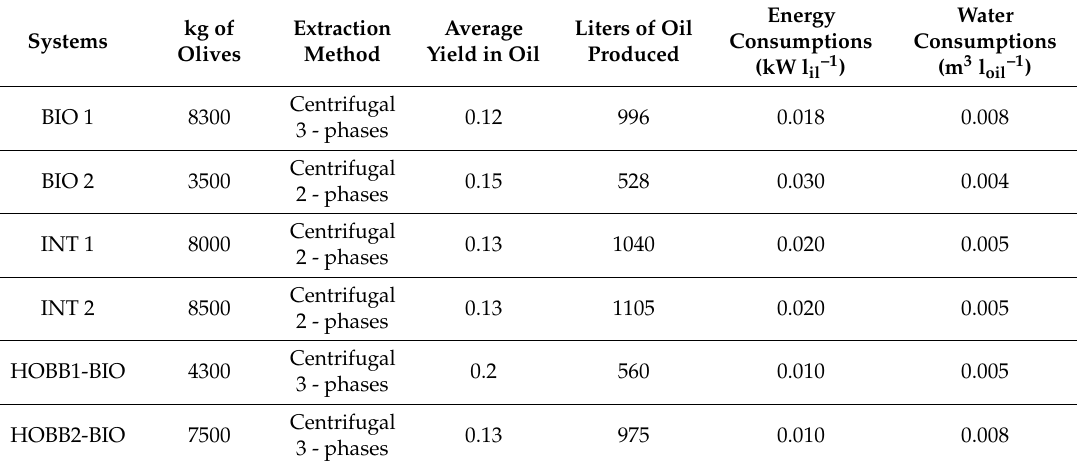
Table 4. Features of the oil mill where olives, collected from the analyzed systems, were processed.